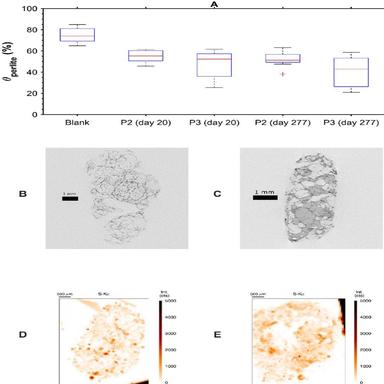
Application of advanced X-ray technology to study the biofilter packing material. (A) Calculated internal porosity (qperlite) of blank perlite, at P2 and P3 at different operation times (day 20 and day 277). (B) mCT scan of a blank perlite particle. (C) mCT scan of a perlite particle at P3 at day 277. (D) and (E) intensity of sulphur elements detected with 2D XRF of a cut section of an epoxy embedded blank perlite particle and a perlite particle at P3 after 20 days.